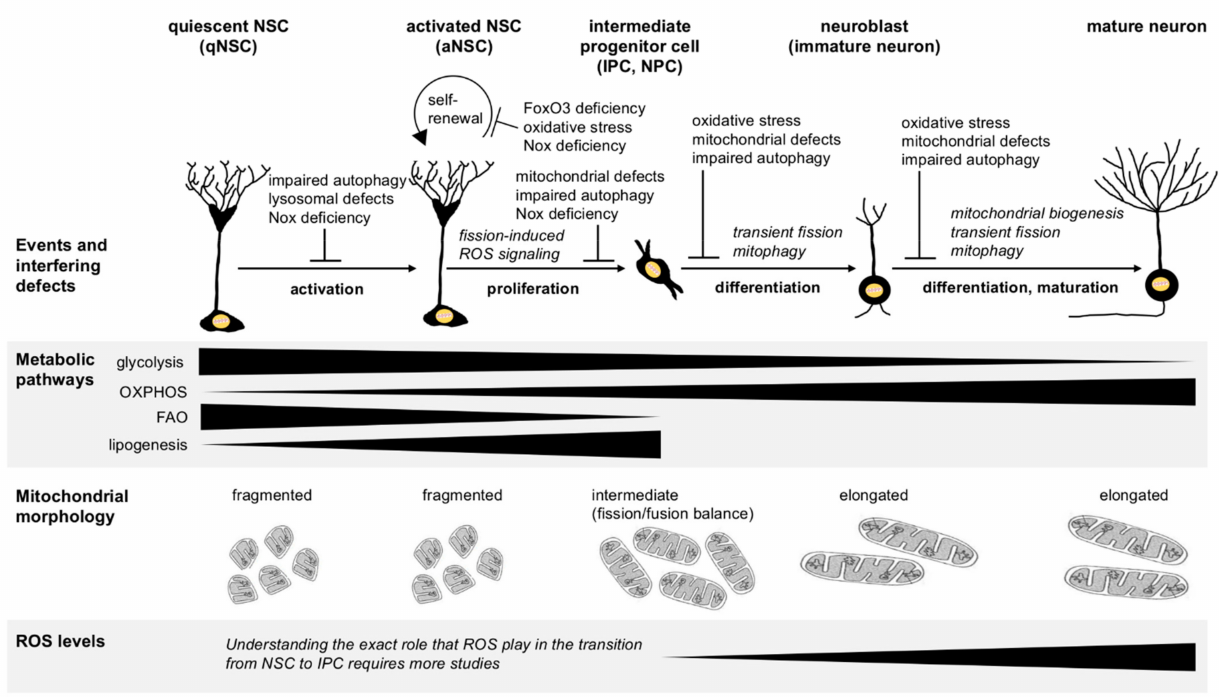
Figure 3. Stage-specific metabolic pathways, mitochondrial dynamics, and ROS regulate cell transition and progression during adult neurogenesis. Neural stem cells (NSC) rely on glycolysis and fatty acid oxidation (FAO) for stemness and self-renewal. An increase of mitochondrial oxidative phosphorylation (OXPHOS) at the expense of FAO and upregulation of de novo lipogenesis in the cytoplasm promote proliferation of NSC and progression toward intermediate progenitor cells (IPC). As IPC begin to differentiate to neuroblasts and further progress to become mature newborn neurons, OXPHOS is crucial to supply the growing cells with sufficient energy. In this phase, mitochondrial biogenesis, fission, and transport are essential to increase mitochondrial content and distribute newly generated mitochondria into the growing and distal branches of maturing dendrites. However, because fragmented mitochondria produce less ATP and fission increases ROS, fission must be transient and followed by fusion. Overall, the mitochondrial morphology changes from fragmented to increasingly elongated during neurogenesis consistent with the progressive reliance of cells on OXPHOS. Reactive oxygen species (ROS) generated by several different NADPH oxidases (Nox proteins) regulate the transition between qNSC and aNSC, NSC renewal, and NSPC proliferation, which has been reviewed elsewhere [79]. In addition, ROS/Nrf2-dependent signaling triggered by mitochondrial fission promotes the transition from aNSC to differentiation-committed IPC. However, the exact role of ROS in this step remains somewhat ambiguous. For more details, please refer to the main